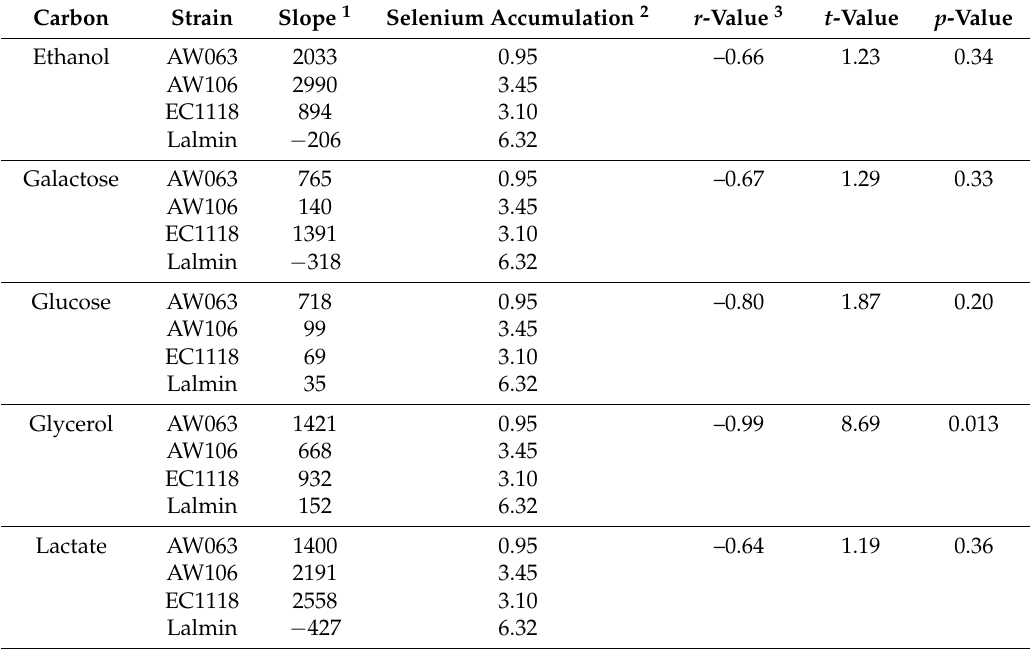
Table 2. Selenite resistance dependence on carbon